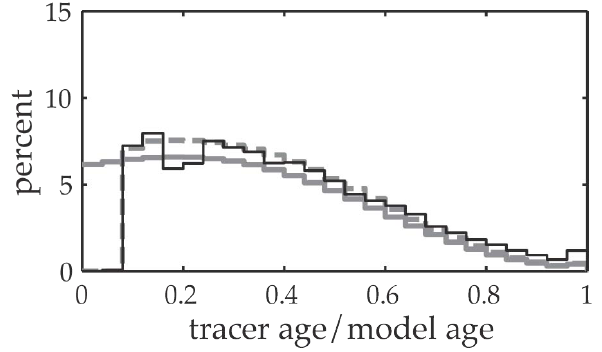
Fig. 10. Histogram of MORB tracer ages (black) compared with the age distribution predicted from the simple sampling theory (solid grey) and with a sampling delay time of 0.4Gyr (Earth time). The tracer ages are given relative to the final model time. After Huang and Davies (2007a). Copyright American Geophysical